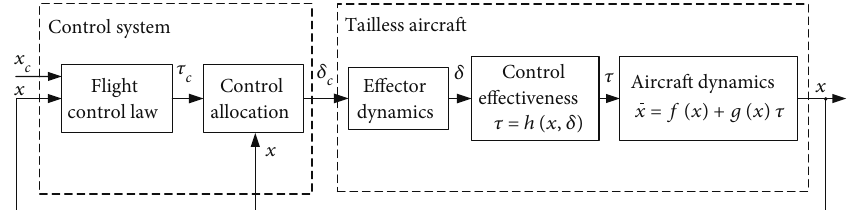
Figure 3: Modular fl ight control system structure of tailless